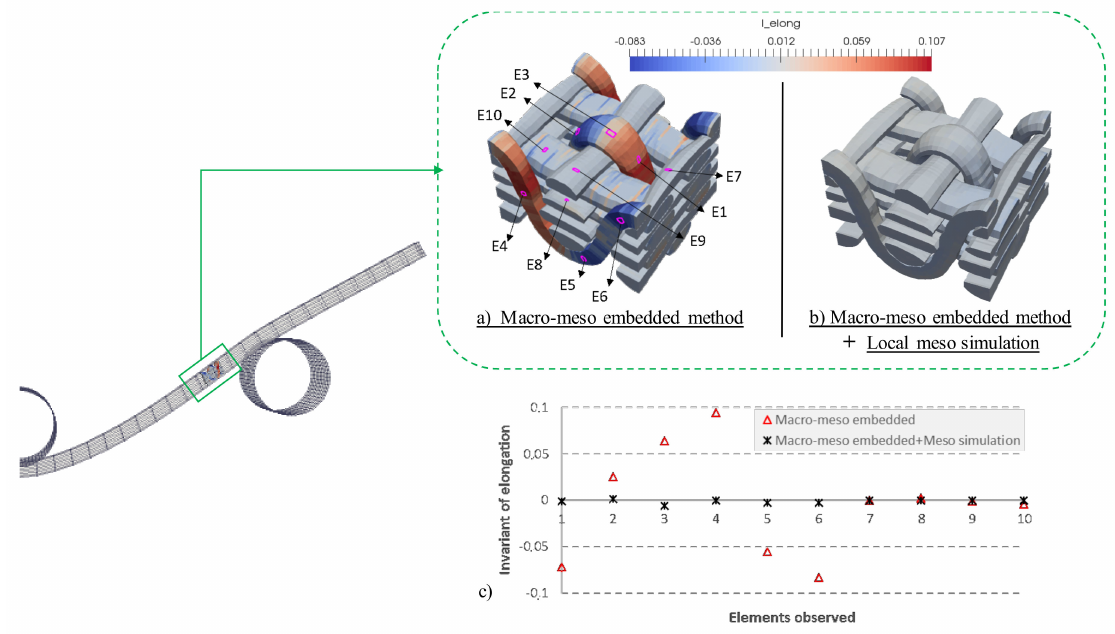
Figure 7. Influence of the enriched local mesoscopic simulation on the elongation of yarns in three- point bending. ( a ) Macro-meso embedded analysis. ( b ) Macro-meso embedded method with local mesoscopic simulation analysis. ( c ) Change in elongation for the same